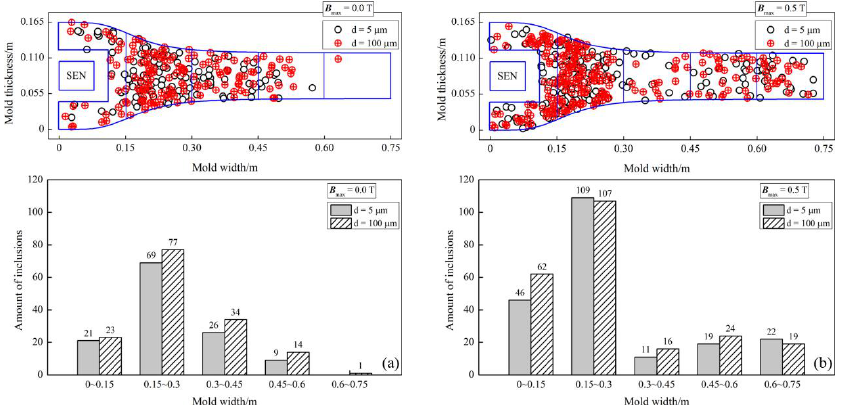
Figure 20. Inclusion distribution on the free surface in the FTSR mold: ( a ) B max = 0 T and ( b ) B max = 0.5